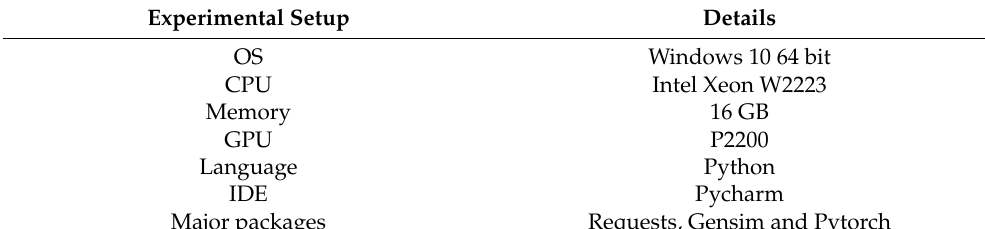
Table 7. Experimental details of the hardware and software platforms.